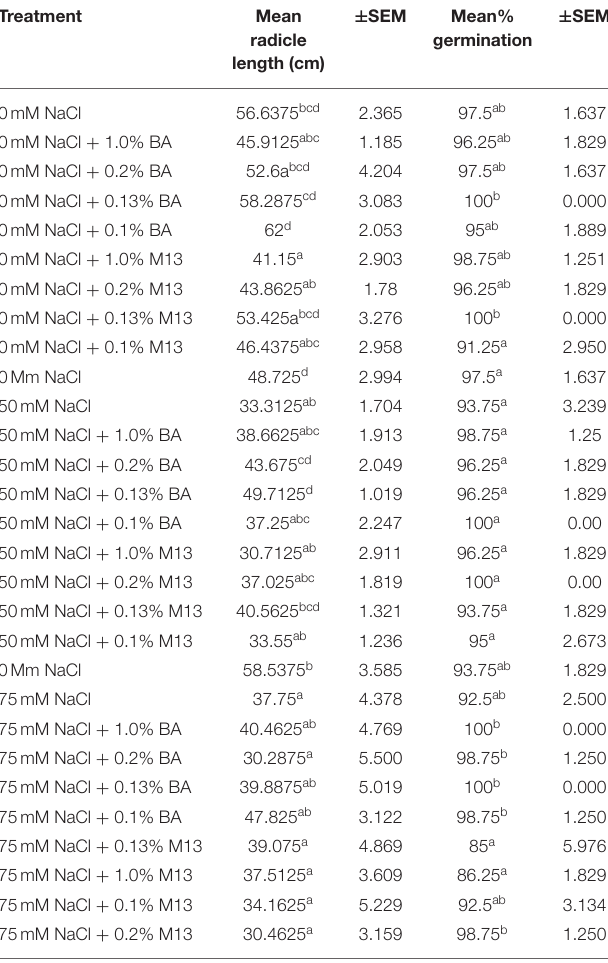
TABLE 7 | Effect of treatment on mean percentage germination of corn exposed to 0, 50, and 75mM NaCl, for 48h.